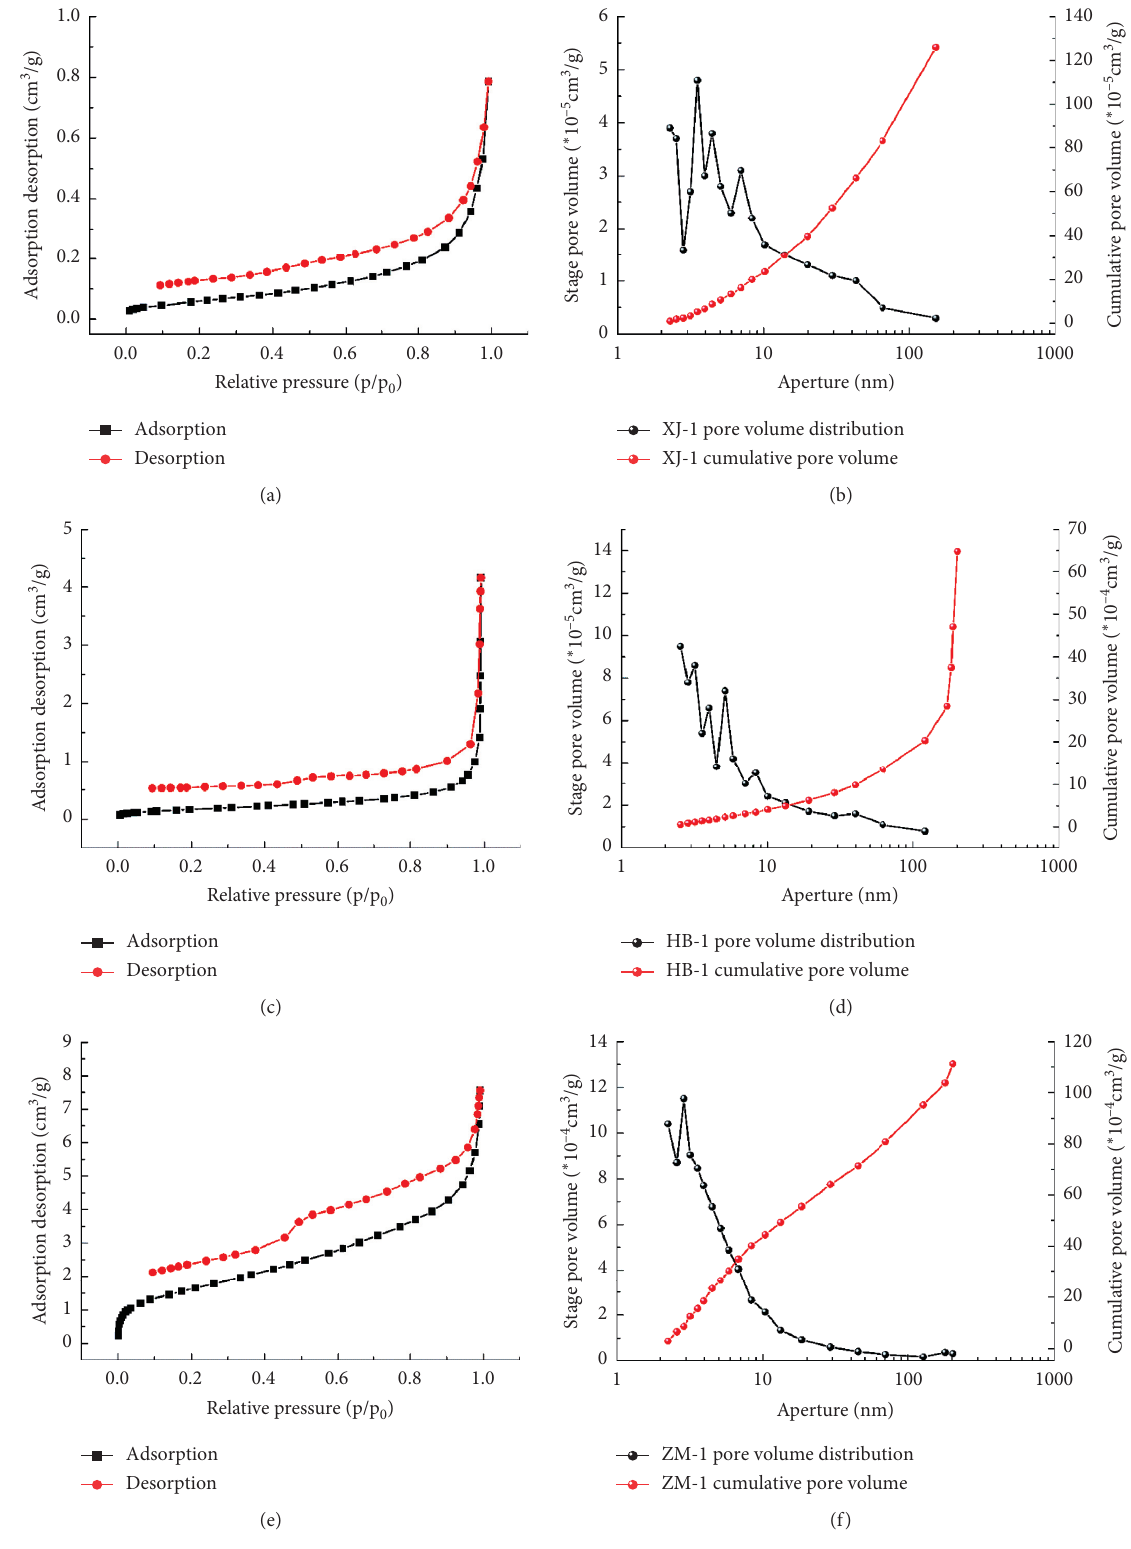
Figure 9: Low temperature liquid nitrogen adsorption curve of coal sample and pore size distribution curve of coal sample. (a) XJ-1, (b) XJ- 2, (c) HB-1, (d) HB-2, (e) ZM-1, and (f)